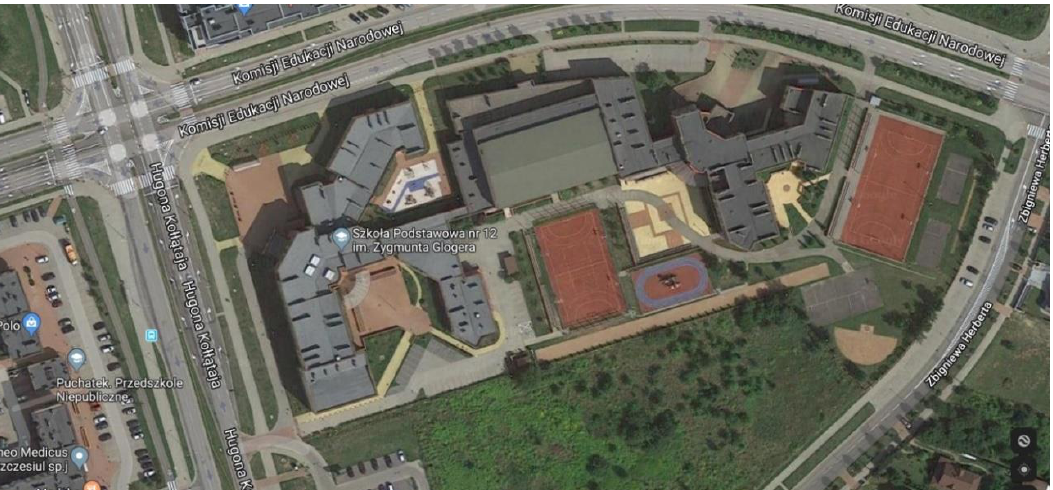
Figure 3. The building under analysis.